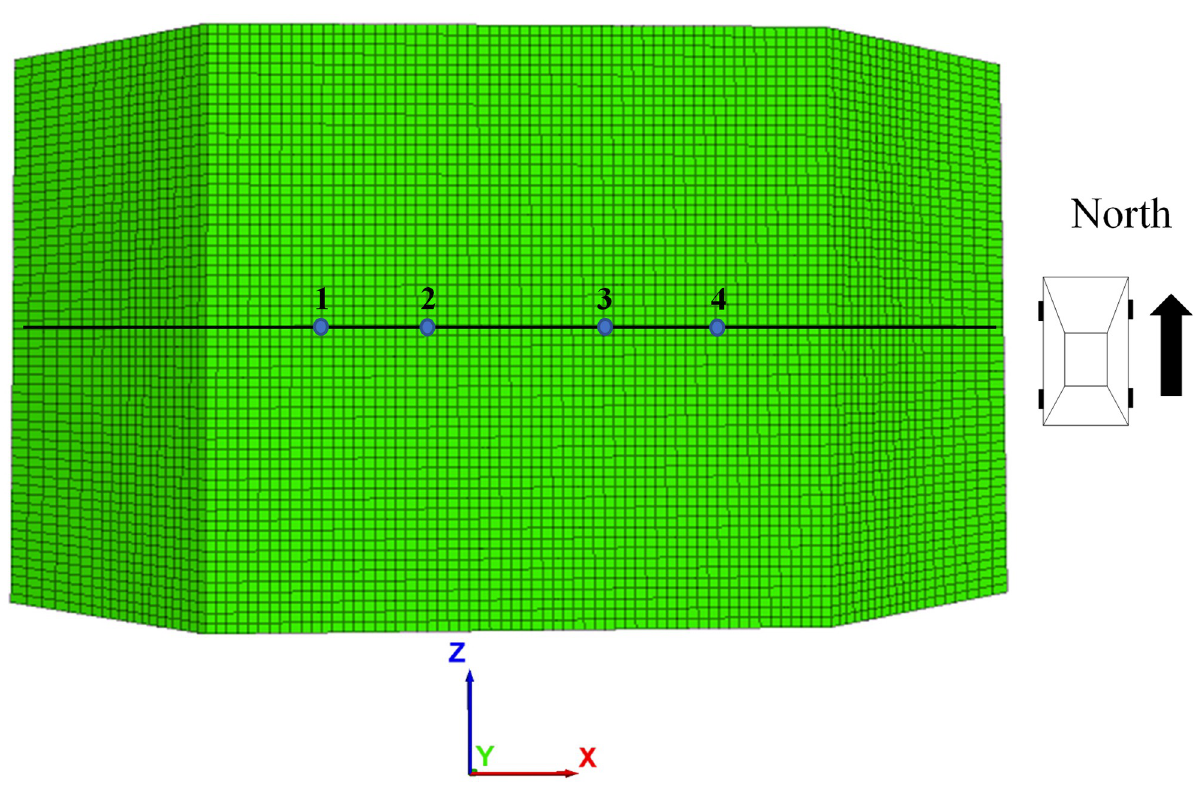
Fig 2. Schematic layout of measurement